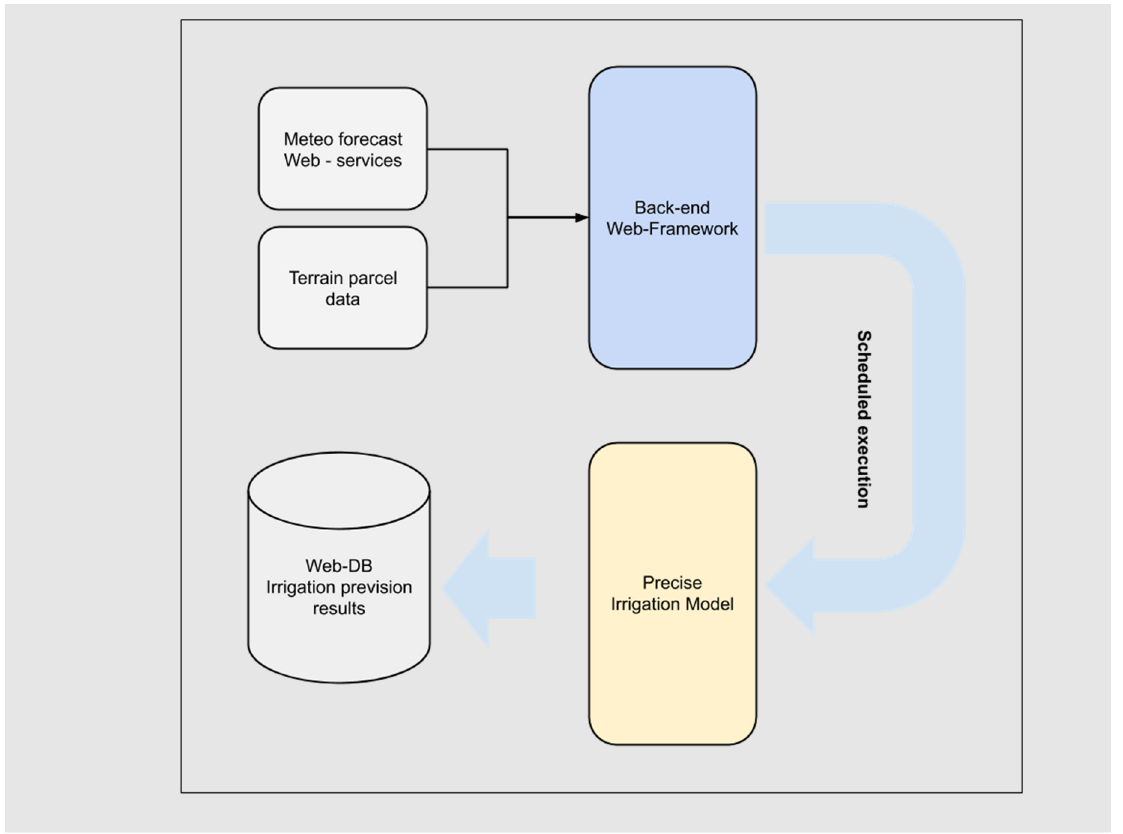
Figure 6. Irrigation model scheduled execution data flow.